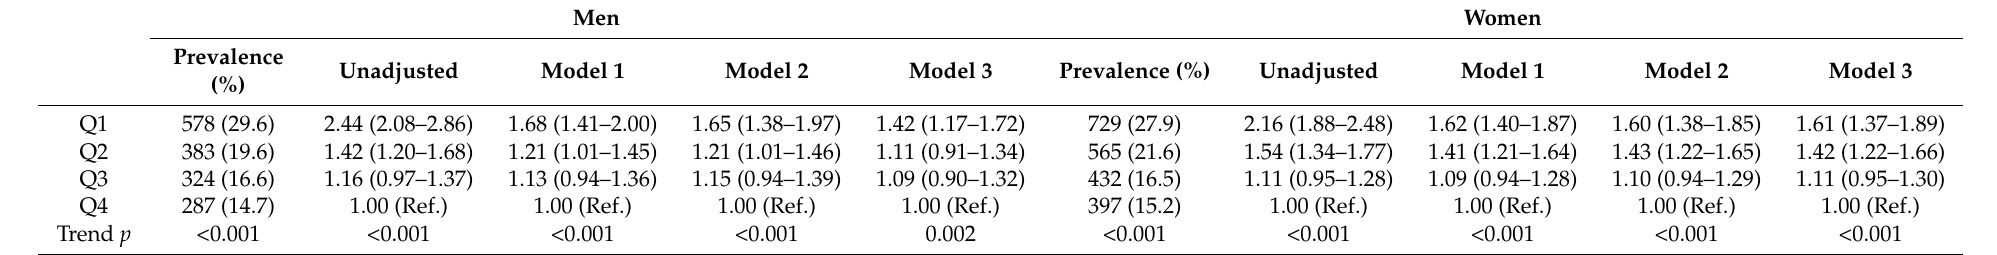
Table 3. Odds ratios (95% CI) of the effect of dietary omega-3 polyunsaturated fatty acids intake on low muscle strength. Men